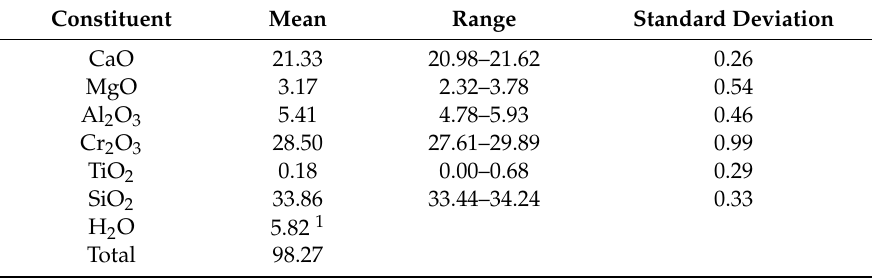
Table 1. Chemical data (in wt %, average of 5 analyses) for shuiskite-(Cr). Constituent Mean Range Standard Deviation CaO